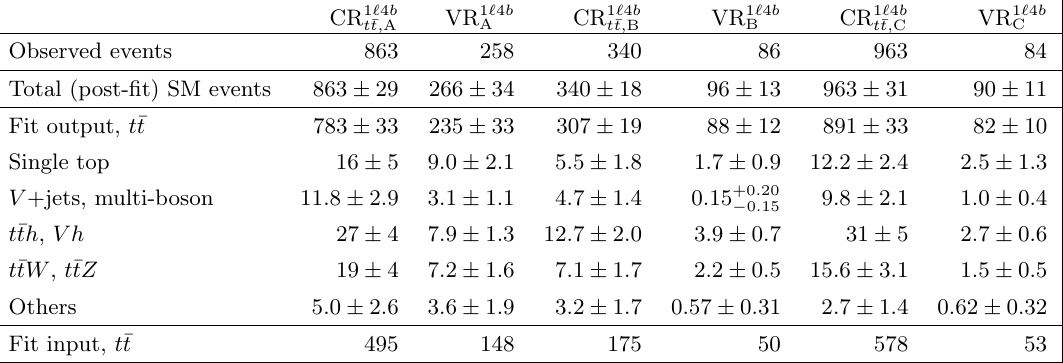
Table 7. Background (cid:12)t results for the control and validation regions in the 1 ‘ 4 b selection. The nominal predictions from MC simulation are given for comparison for the t (cid:22) t background, which is normalised to data. The \Others" category contains the contributions from t (cid:22) tWW , t (cid:22) tt , t (cid:22) tt (cid:22) t , tZ , and tWZ production. Combined statistical and systematic uncertainties are given. The individual uncertainties can be correlated and do not necessarily add in quadrature to the total systematic